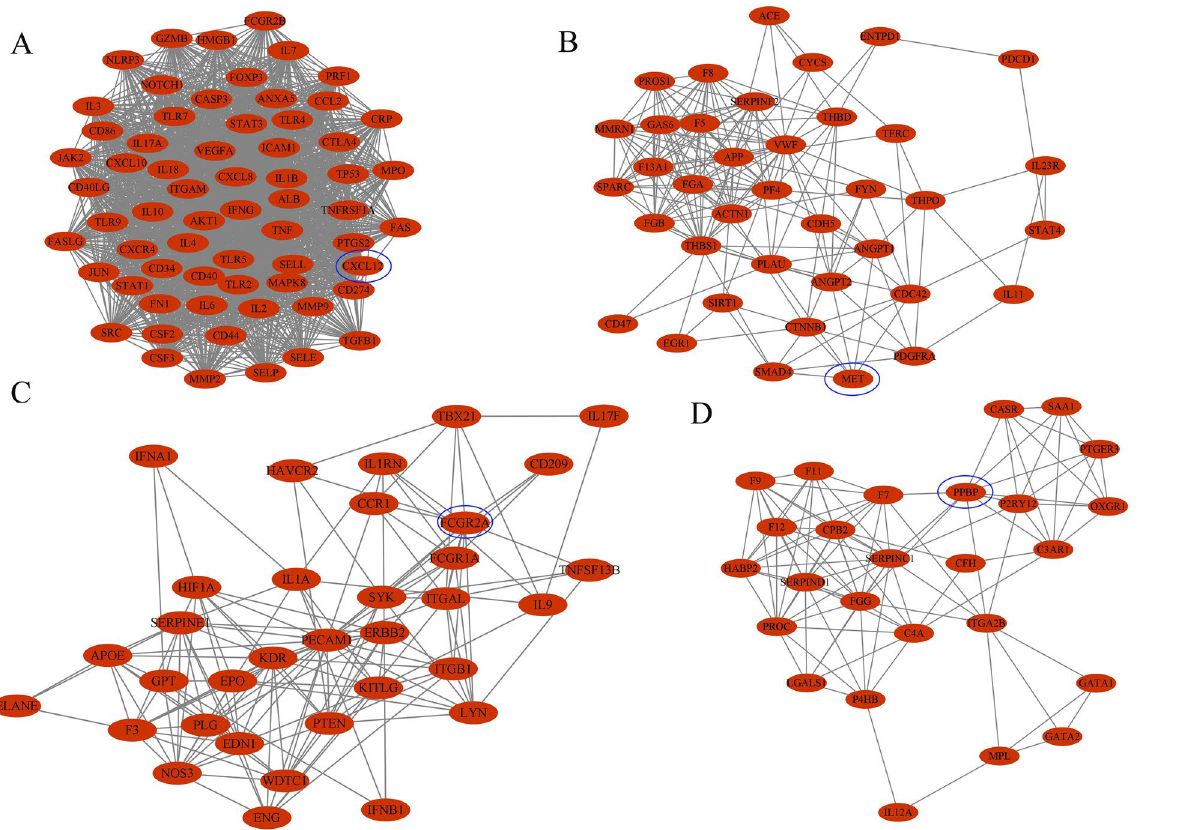
Figure 5. Clusters of thrombus-related targets PPI network. ( A – D ) are clusters we found in the thrombus- related targets PPI network which stands for cluster 1 to 4, respectively . The seed node of each clusters is marked with blue circles.